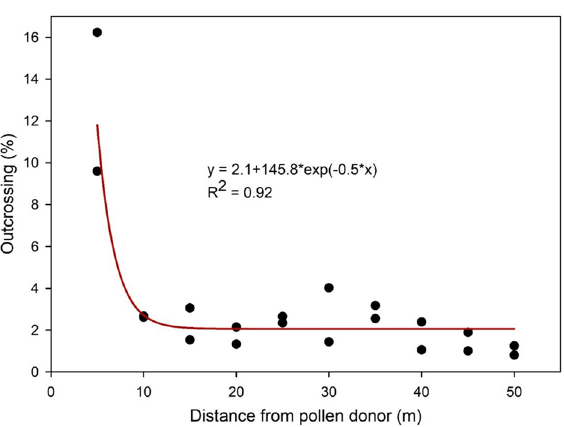
Figure 5. An exponential decay curve [f = y0 + a × exp(− b × x)] showing mean outcrossing (y) as a function of distance (x) from the pollen source, averaged among all directions across three study